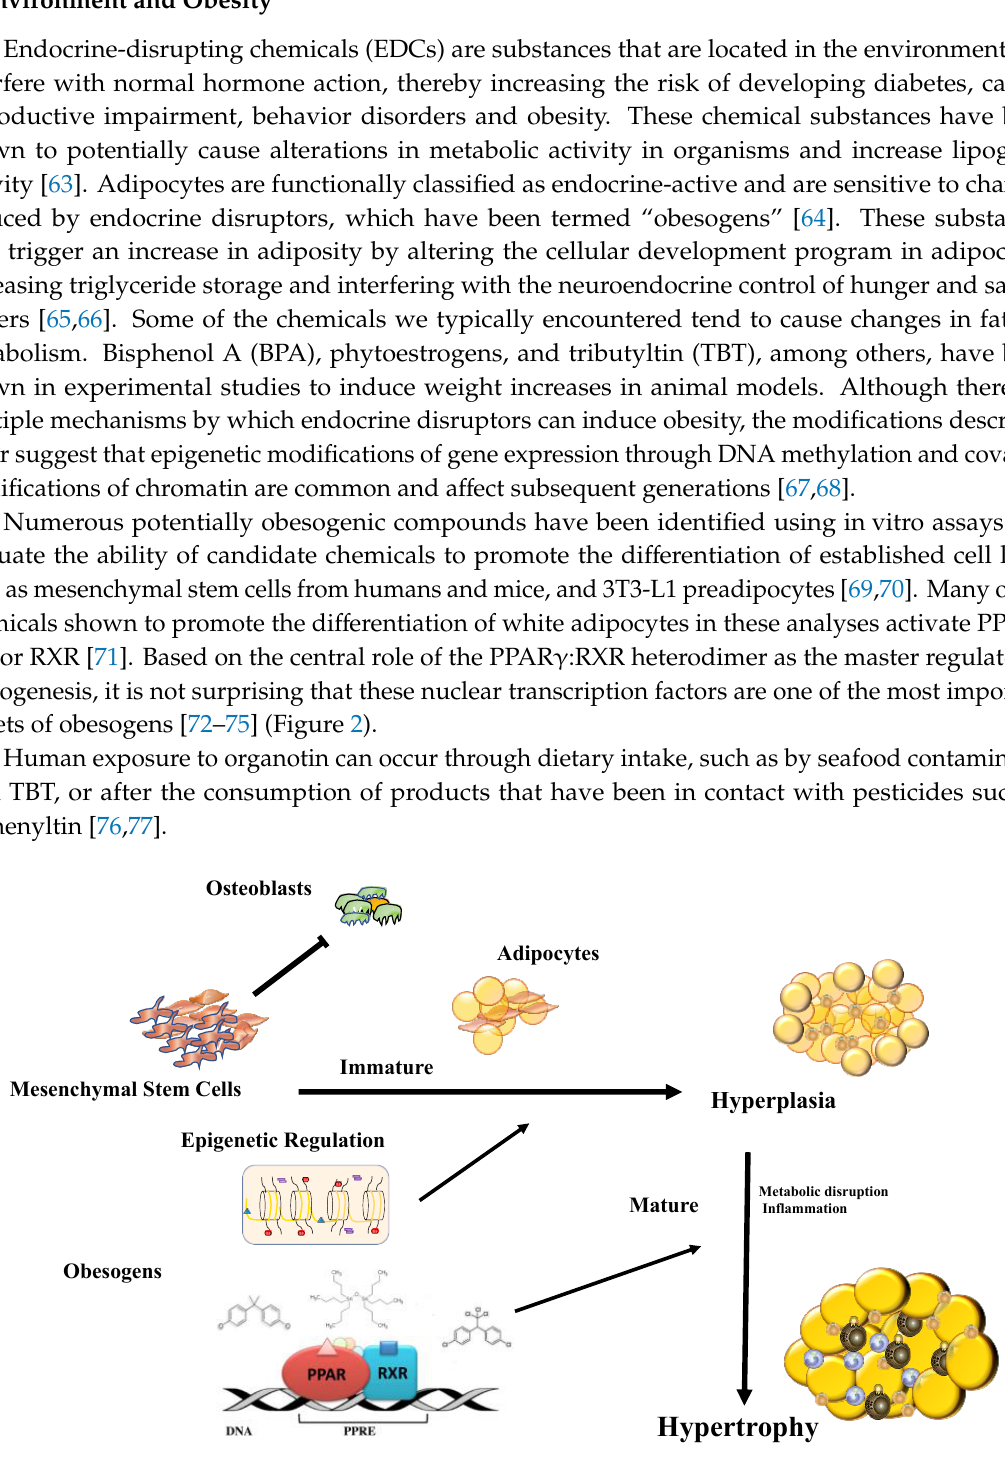
Figure 2. Chemical substances with the ability to modify thermogenesis primarily act through PPAR γ :RXR receptors, the masters of adipocyte di ff erentiation. Other changes that obesogenic substances can induce are epigenetic modifications (DNA methylation, covalent modifications of histones, and noncoding RNA). Obesogens can induce mesenchymal cells to direct di ff erentiation towards the adipocyte line and reduce osteoblastic activity. Then, the obesogens induce hyperplasia of adipocytes and later produce hypertrophy with an accumulation of inflammatory cells that produce the secondary e ff ects of obesity.